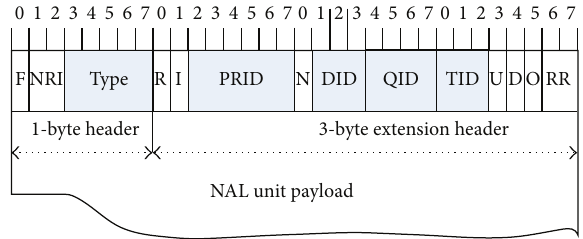
Figure 6: Internal structure of an H.264/SVC NAL